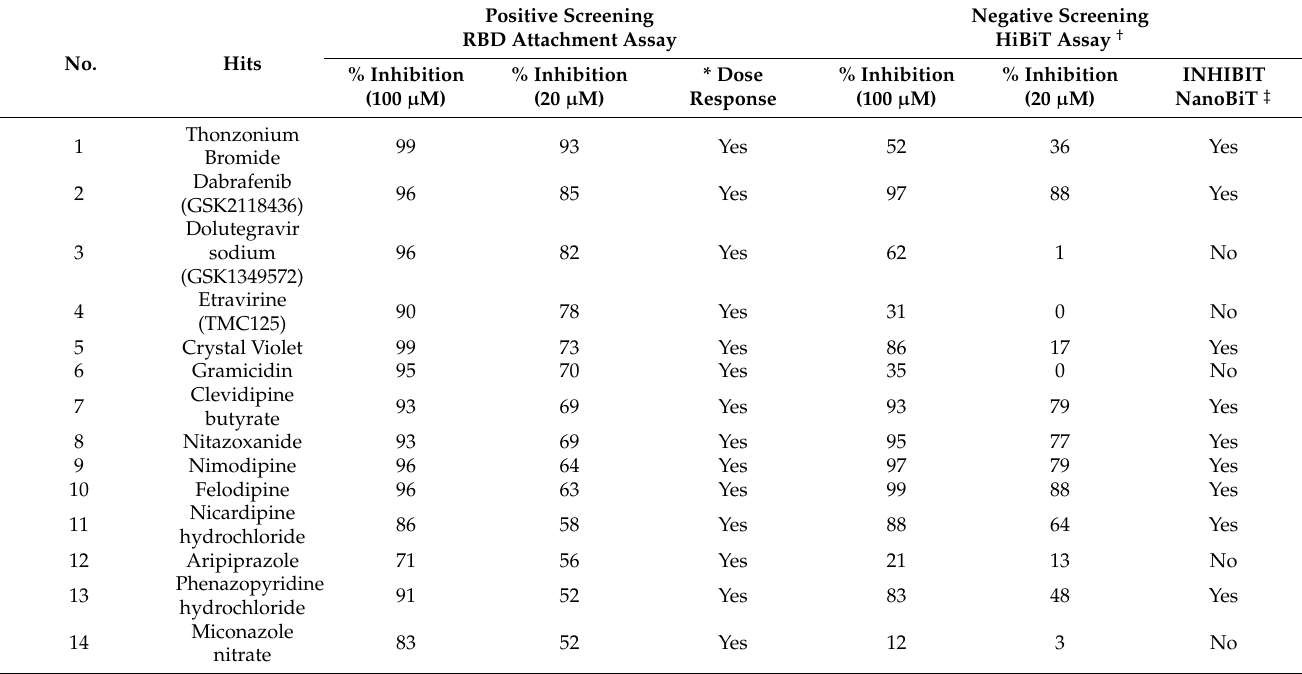
Table 1. Top 20 hits of entry inhibitors in the initial